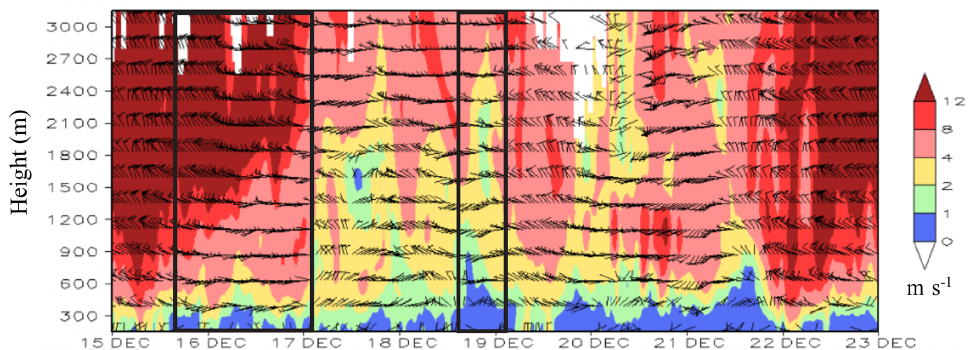
Figure 4. Hourly wind profile from 15 to 23 December. Wind speed (shading; ms − 1 ) and horizontal wind field (vector; ms − 1 ). The black boxes show the two periods of south-wind